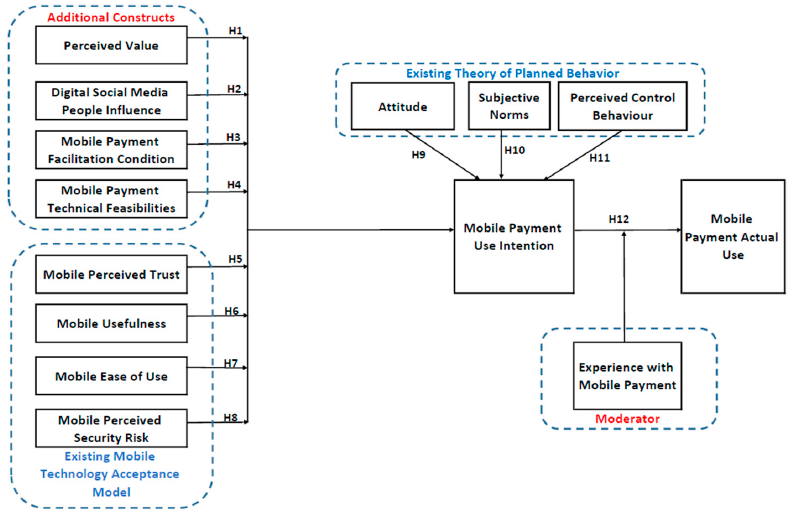
Figure 1. Proposed revised mobile payment technology acceptance model and behaviour (MPTAMB) and the proposed hypothesis.